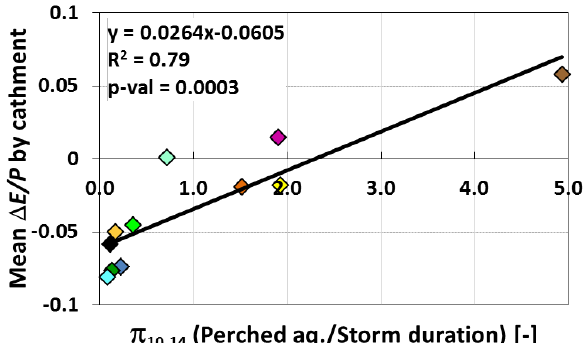
Figure 9 Fig. 9. Correlation between mean 1E/P by catchment and the di- mensionless number from the ratio of the perched aquifer and storm duration time scales (sample size: 12; p value: